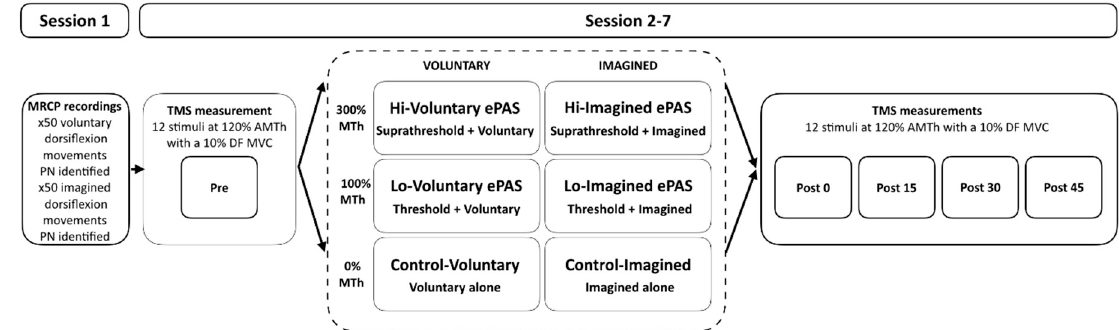
Figure 1. Schematic illustration of the factorial study design with six intervention conditions. MRCP, movement-related cortical potential; DF, dorsiflexor; PN, peak negativity; TMS; transcranial magnetic stimulation; AMTh, active motor threshold; MTh motor threshold; MVC, maximum voluntary contraction.